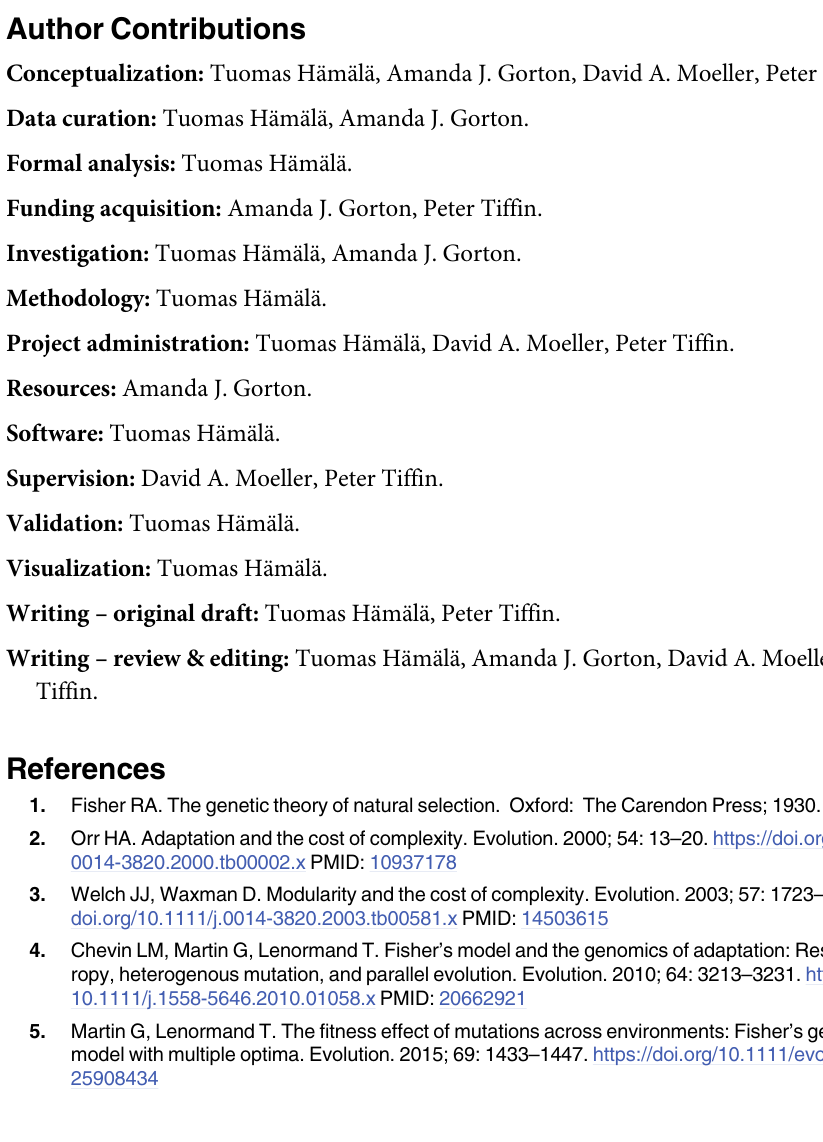
S1 Table. Pairwise F estimates among the sampled populations. ST S2 Table. Genetic diversity estimates for the study populations. S3 Table. PCA loadings for the 19 BIOCLIM variables and the proportion of variance explained (PVE) by the